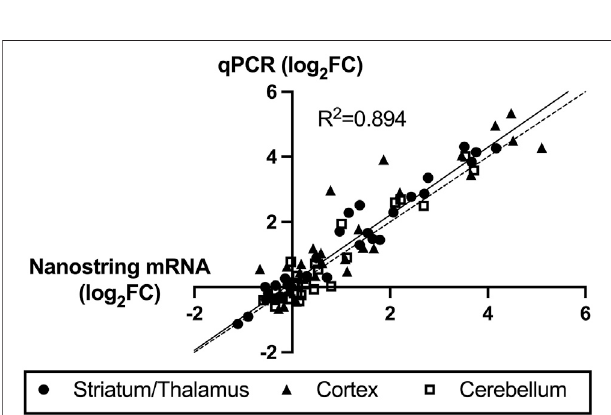
FIGURE 6 | Correlation between Nanostring RNA sequencing and quantitative polymerase chain reaction (qPCR) validation of seven highly expressed mRNAs. The x -axis values are Nanostring log 2 fold-change (FC, hypoxic-ischemicbraininjuryversuscontrol)valuesand y -axisareqPCR ΔΔ Ct log fi t regression of the 2 FC values. The solid line represents the best- datapointswithstrongcorrelation(R 2 =0.894)andthedashedlinerepresents the ideal correlation line (x =